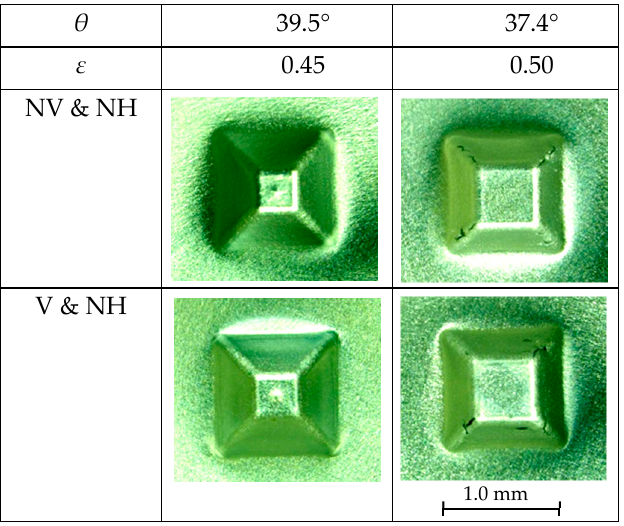
Figure 6. Forming limits for truncated pyramids with and without ultrasonic vibration (V and NV) and without laser heating (NH).